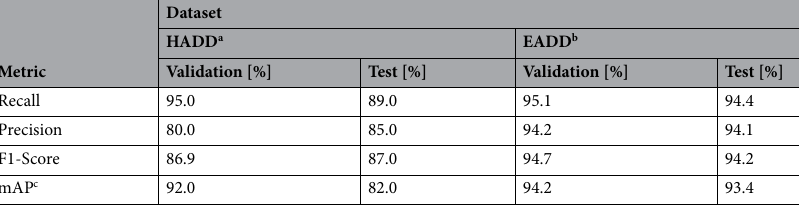
Table 4. Detection results while training two versions of FIN-DETECT with respect to HADD and EADD. a HADD Human-Annotated Detection Dataset. b EADD Extended-Annotated Detection Dataset. c mAP mean Average